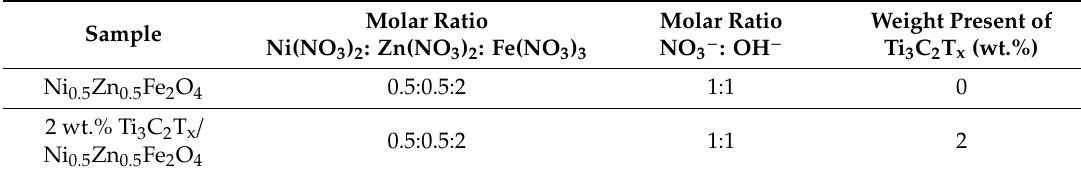
Table 1. Characteristics of the synthesized